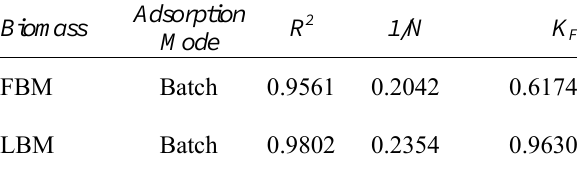
Figure 10: Freundlich Adsorption Isotherm For Batch Study using LBM